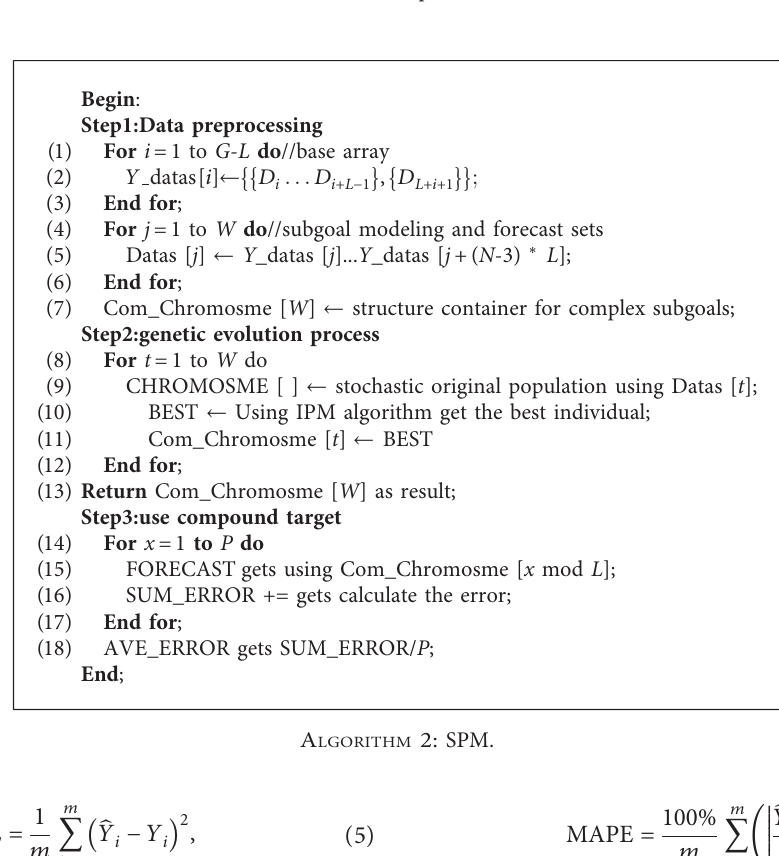
Figure 3: Principle of